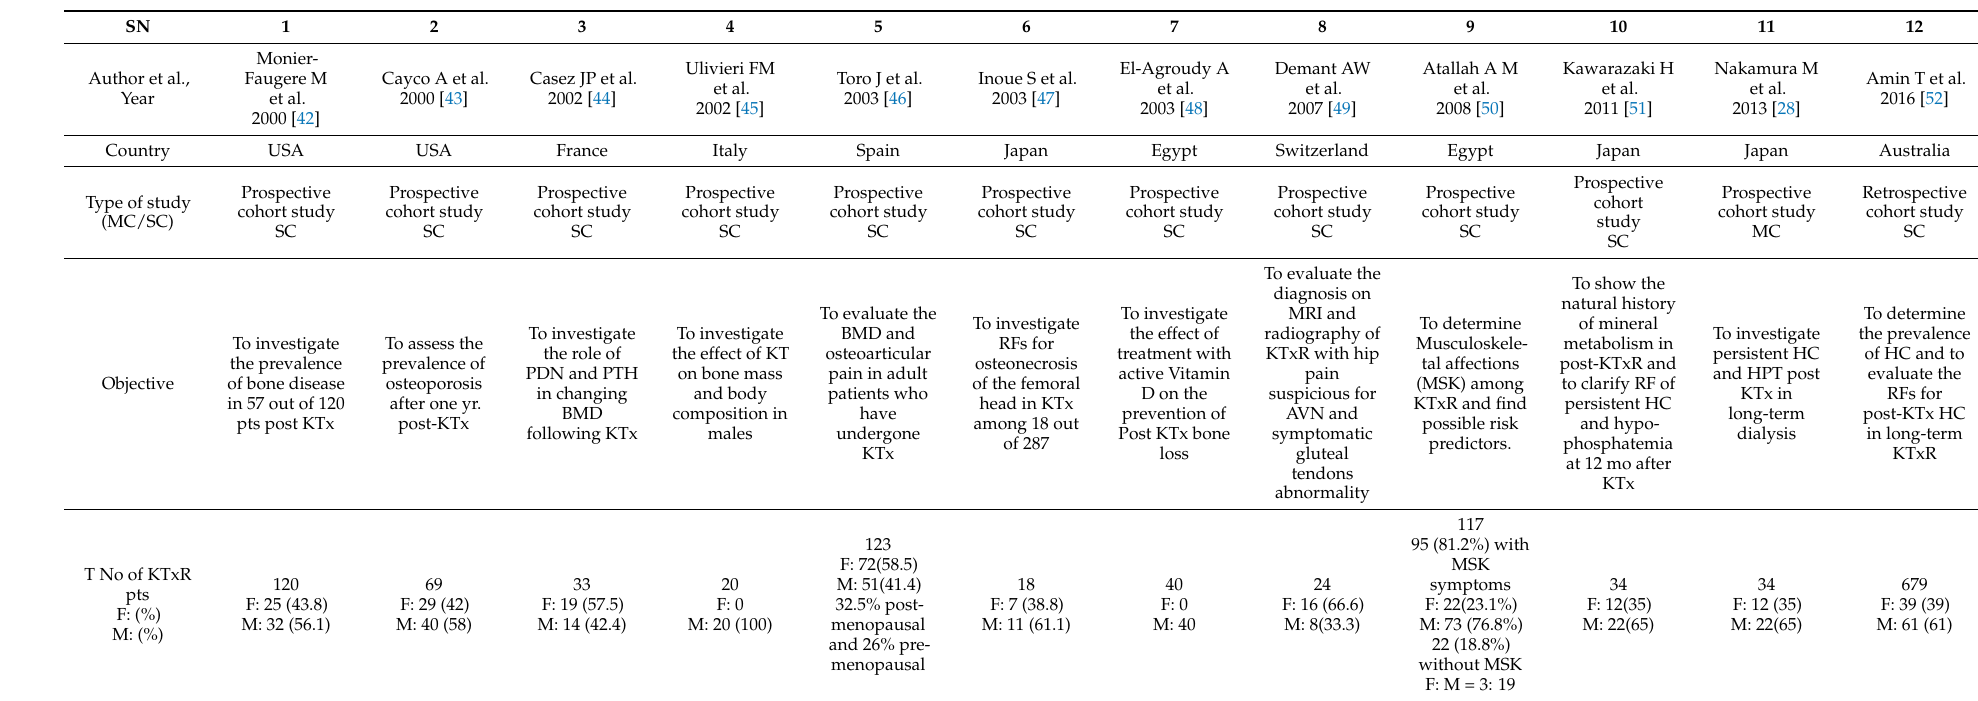
Table 3. Prevalence of Bone loss in adult post kidney transplant recipients (KTxR) included in this systematic